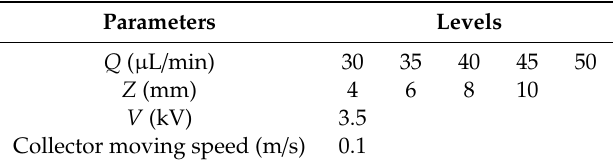
Table 1. The process parameters of EHD direct-writing.